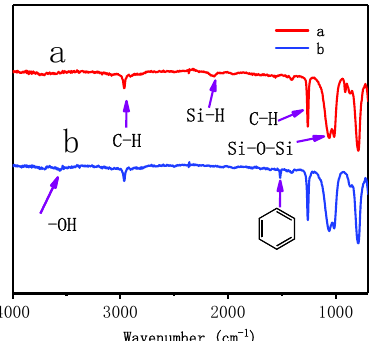
Figure 5. Fourier transform infrared (FT–IR) spectrum of hydrogenterminated siloxane ( a ) and biophenol terminated siloxane ( b ).